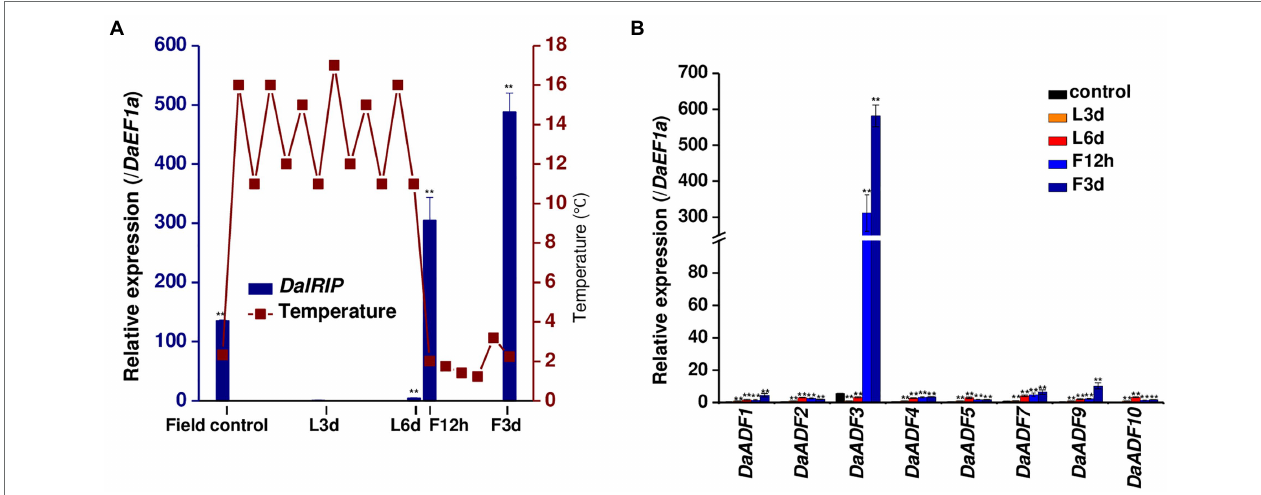
FIGURE 2 | Expression profiles of DaADF homologs in response to different growth conditions in the Antarctic field and the laboratory. (A) Expressional changes of DaIRIP in response to different growth conditions. Deschampsia antarctica plants were collected in Antarctica (Field control) and incubated under laboratory conditions for 3 days (L3d) and 6 days (L6d), and then transferred back to the Antarctic field for 12 h (F12h) and 3 days (F3d). (B) Expression patterns of eight DaADF genes in response to the Antarctica field and laboratory conditions in D. antarctica plants. Total RNA was isolated from each sample and used for reverse- transcription quantitative polymerase chain reaction (RT-qPCR) analysis using a gene-specific primer set ( Supplementary Table 2 ). The relative expression of each gene was normalized to that of DaEF1a as an internal control. Data are means ± standard deviation (SD) of three biologically independent experiments (** p < 0.01, Student’s t -test).